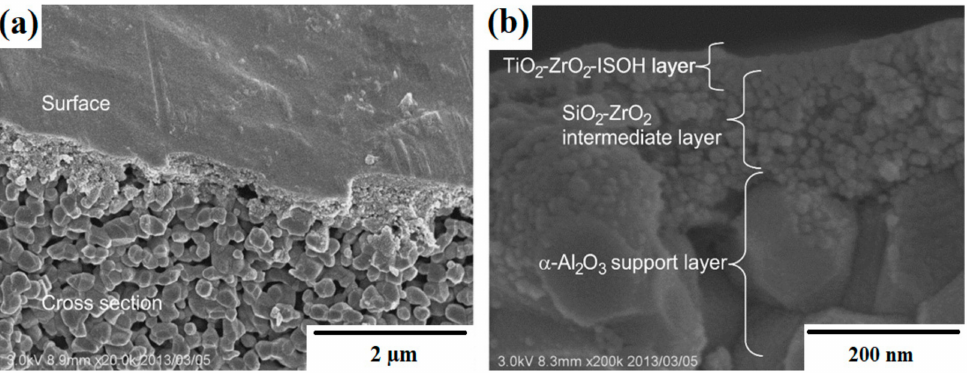
Figure 11. SEM images of surface and cross-section views of a TiO 2 –ZrO 2 –ISOH membrane calcined at 350 ◦ C under N 2 : ( a ) surface and cross-section views at 20,000 × ; ( b ) cross-section view at 200,000 × (created based on [193] with permission from Elsevier